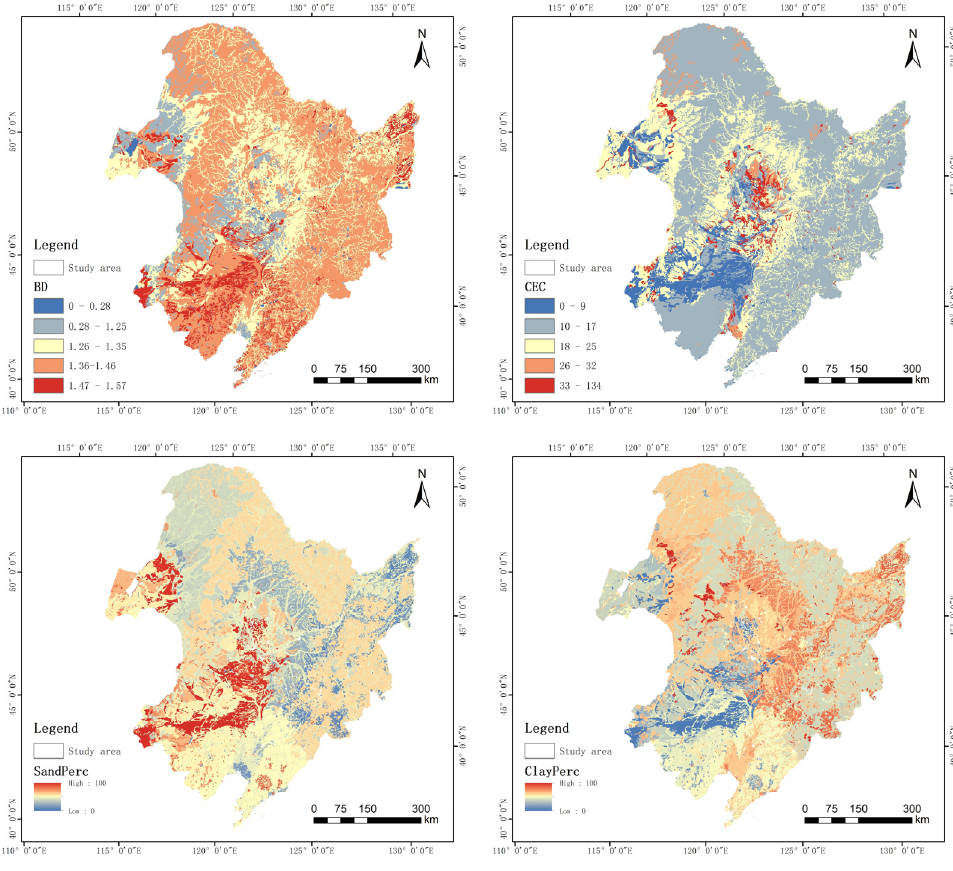
Figure 3. Spatial distribution of environmental variables. Table 1. Mean value of environmental variables for each zone.